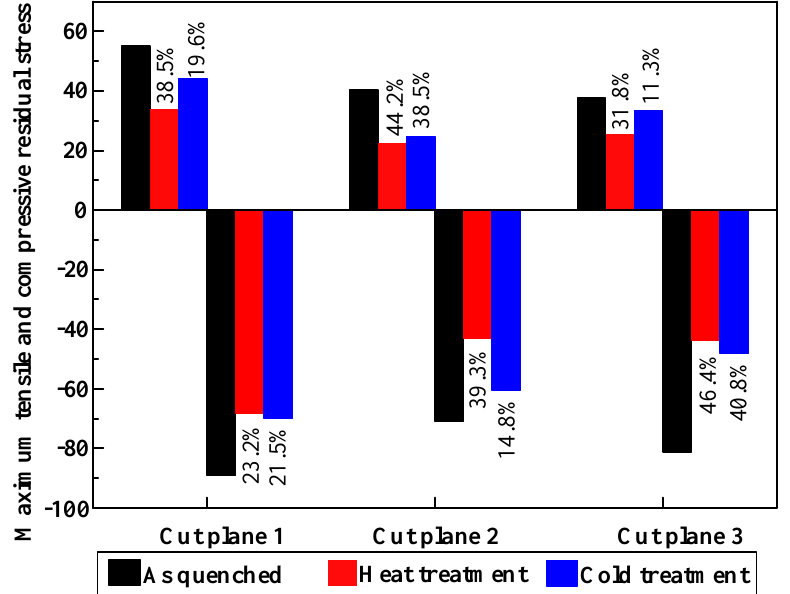
Figure 13. Maximum tensile (+) and compressive (−) residual stress in different cut planes with three treatment processes. The percentage means the maximum stress reduction of heat and cold post-treatment compared with the as-quenched specimen.